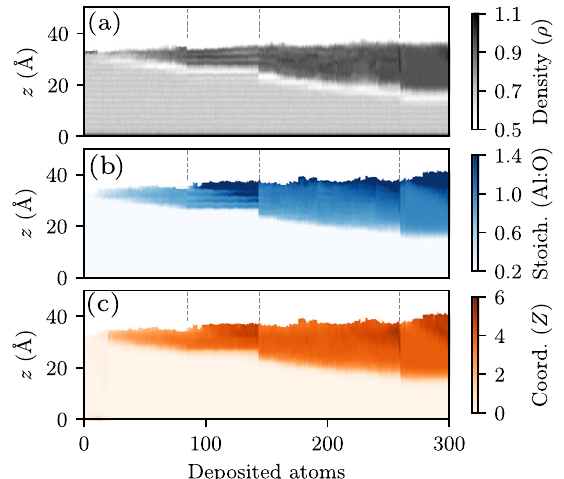
Fig. 4 Structural properties during the oxidation simulation. a Density of the aluminium – aluminium oxide structure shown as a function of position and deposition progress. The dashed lines mark the points where structural changes occur as the surface oxide changes form or a layer of the aluminium substrate is consumed by the oxidation process. b Variation of the stoichiometric ratio between oxygen and aluminium over the course of the oxidation simulation. c Coordination of oxygen atoms about aluminium over the course of the oxidation simulation. This calculation was performed with the S – M